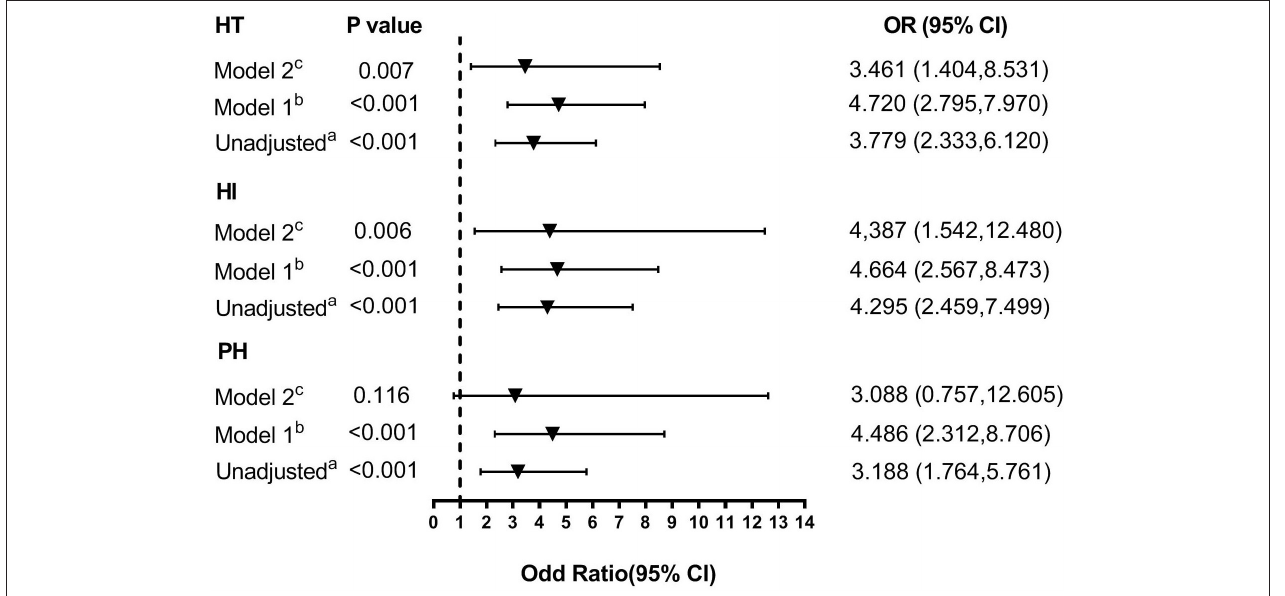
FIGURE 4 | Multivariate adjusted odds ratios for the association between FIB-4 score and the subcategorized groups of HT (including HT, HI, and PH, respectively). OR, odds radio; CI, confidence level; HI, hemorrhagic infarct; HT: hemorrhagic transformation; PH, parenchymal hematoma. (A) Reference OR (1.000) is an FIB-4 score < 2.68. (B) Model 1: adjusted for age and sex. (C) Model 2: adjusted for covariates from Model 1 and further adjusted for vascular risk factors (history of hypertension, atrial fibrillation, diabetes, dyslipidemia, and current smoking) and systolic blood pressure, stroke mechanism, size of the infarction area, baseline NIHSS score, baseline white cell counts, fibrinogen, total cholesterol, and anticoagulant, antiplatelet, and lipid-lowering